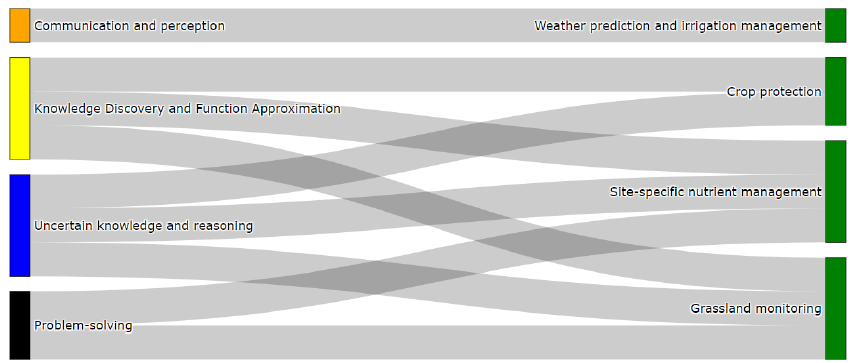
Figure 11. Agriculture problems classified by the proposed